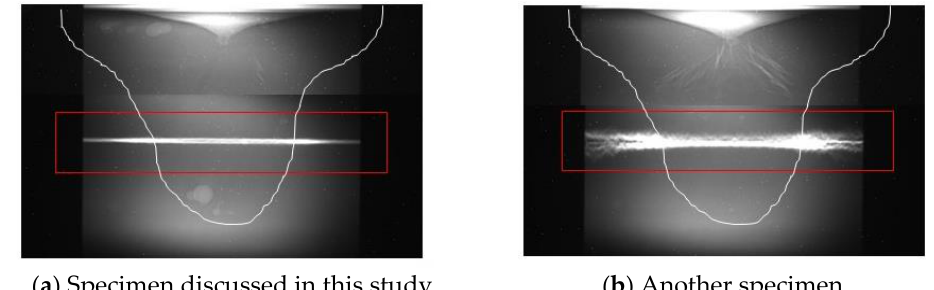
Figure 10. Transmission imaging of the lap joint.